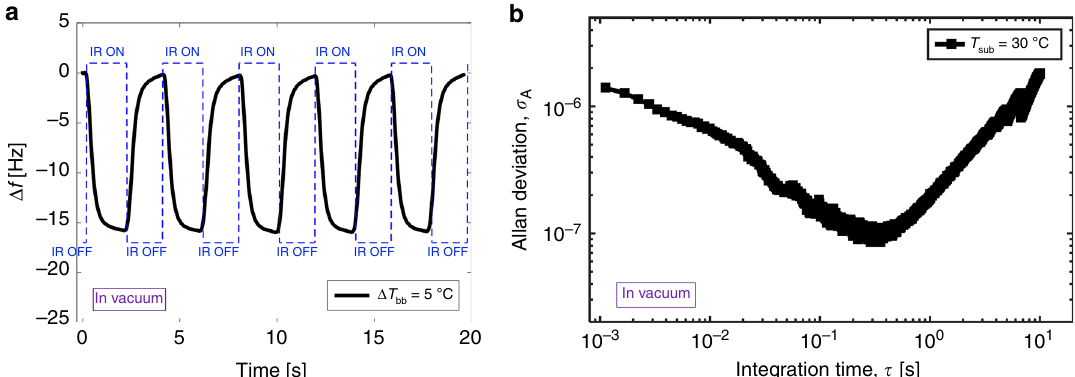
Fig. 5 NETD measurements of the SiNx/SMP IR sensor. a The frequency response of the composite SiNx/SMP IR sensor in vacuum at T sub = 30 °C operation temperature when the target temperature is periodically changed by Δ T bb = 5°. b Allan Deviation measurements as a function of integration time at T sub = 30 °C for the SiNx/SMP resonant IR sensor in vacuum (~10 – 3